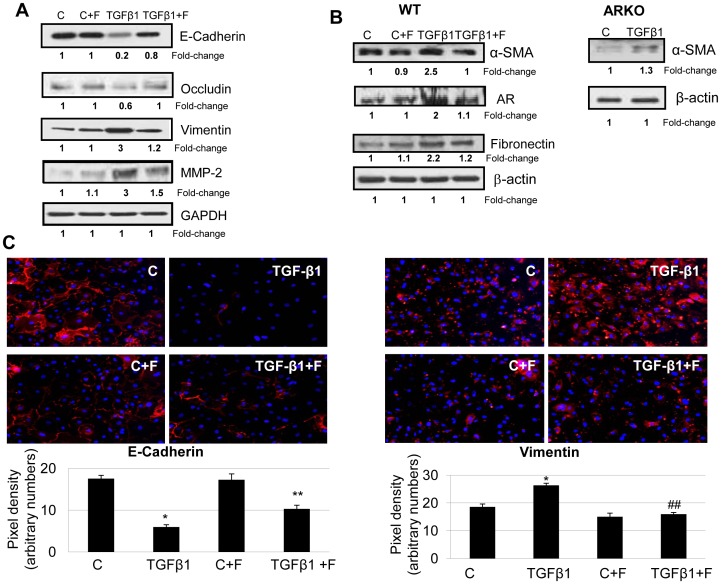
AR inhibition prevents TGFβ1-induced changes in EMT marker proteins in SAECs and mLFs.The (A) SAECs, and (B) mLFs derived from wild-type (WT) and AR-knockout (ARKO) mice were treated with TGFβ1 for 72 h, cell lysates were prepared and equal amounts of protein were analyzed for the expression of EMT marker proteins by Western blot analysis (n = 4). The numbers below the blots indicate fold-change in the band intensities. (C) The cells on chambered slides were fixed and immunostained with E-cadherin or vimentin specific antibodies using Texas red-labeled goat anti-rabbit secondary antibodies and mounted with floursave mounting medium containing DAPI. The photomicrographs were acquired by fluorescence microscopes. A representative field for each group is shown (magnification: 200×); (n = 4). The Bar diagrams below the photomicrographs indicate respective pixel densities showing relative changes in the expression. *p<0.01 Vs Control; **p<0.05 Vs TGFβ1 alone; ##p<0.01 Vs TGFβ1. C, control; F, fidarestat; TGFβ1, transforming growth factor-beta 1.